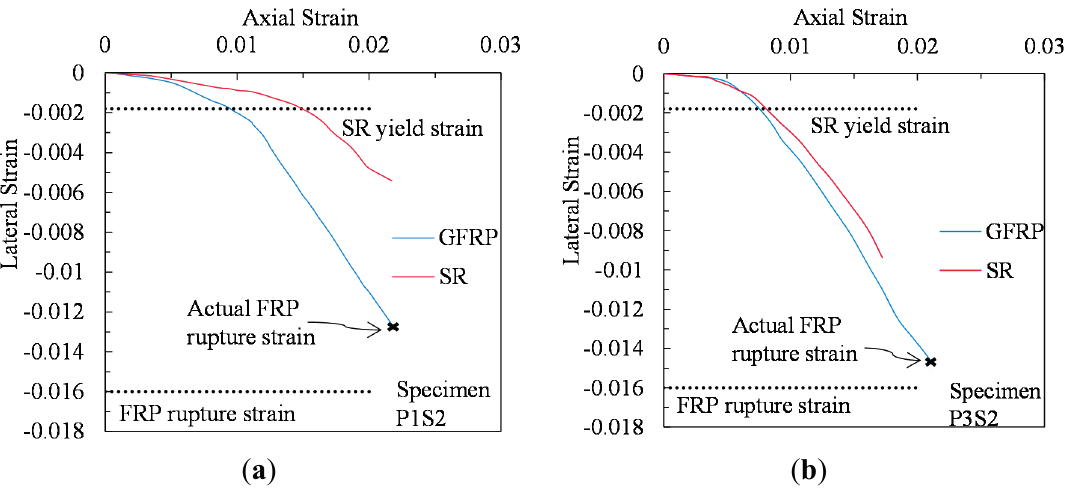
Figure 9. Lateral strain developed in the SR and FRP for specimens ( a ) P1S2 and ( b )